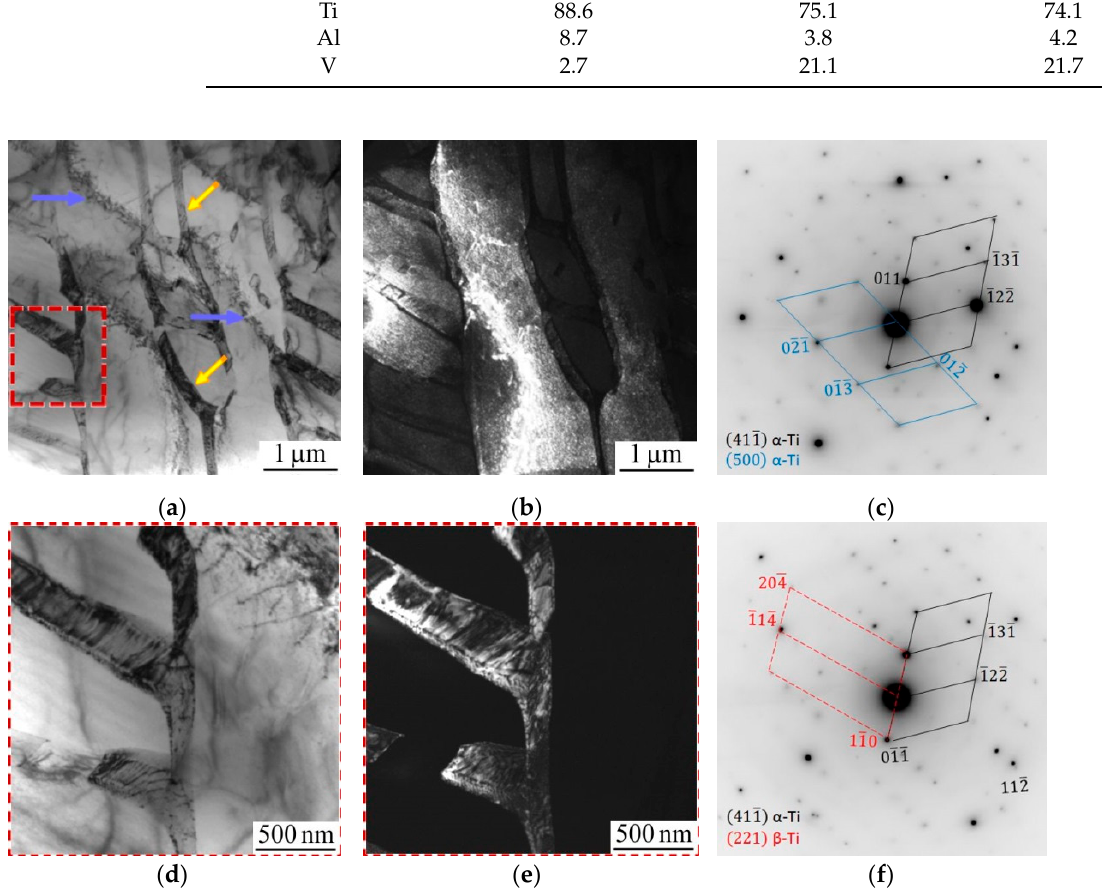
Figure 5. Bright- ( a , d ) and dark-field TEM micrographs ( b , e ) and the associated SAED patterns with indexing schemes ( c , f ) of the microstructures of the EBAM Ti-6Al-4V samples produced without substrate cooling. Dashed red line box in ( a ) highlights the area that is enlarged in ( d , e ). The dark-field TEM micrographs were obtained with the closely spaced 021(cid:4666)500(cid:4667) α -Ti and 122(cid:3435)411(cid:3439) α -Ti reflections ( b ) and the closely spaced 011(cid:3435)411(cid:3439) α -Ti and 110(cid:4666)221(cid:4667) β -Ti reflections ( e ). The microstructure was obtained at a distance of 40 mm from the substrate.